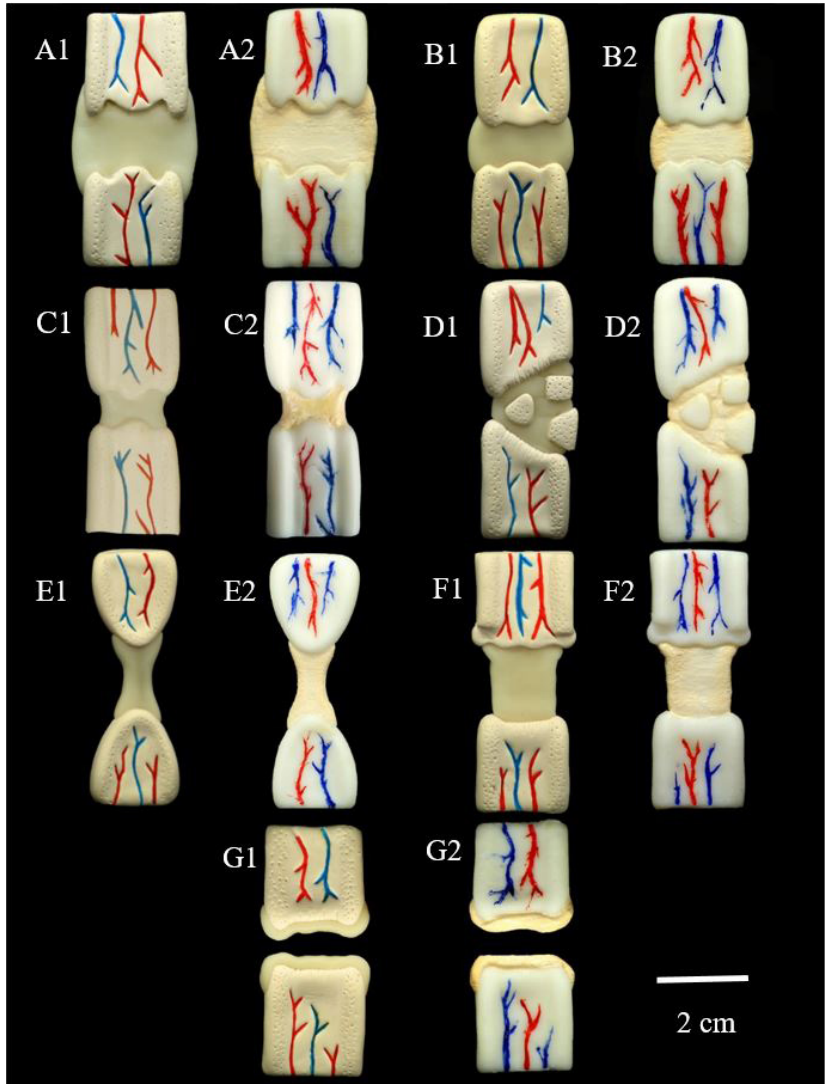
Figure 2. Representation of the classification of non-union of fractures. (A) Hypertrophic or Elephant’s foot; (B) Slightly hypertrophic or Horse’s roof; (C) Hypotrophic; (D) Comminuted; (E) Atrophic; (F) Torsion wedge; (G) Bone gap; 1. Biscuit model of different types of fracture non-union; 2. 3D models of fracture non-union. Classification of types of fracture non-union after Denny & Butterworth (2006), Weber & Cech